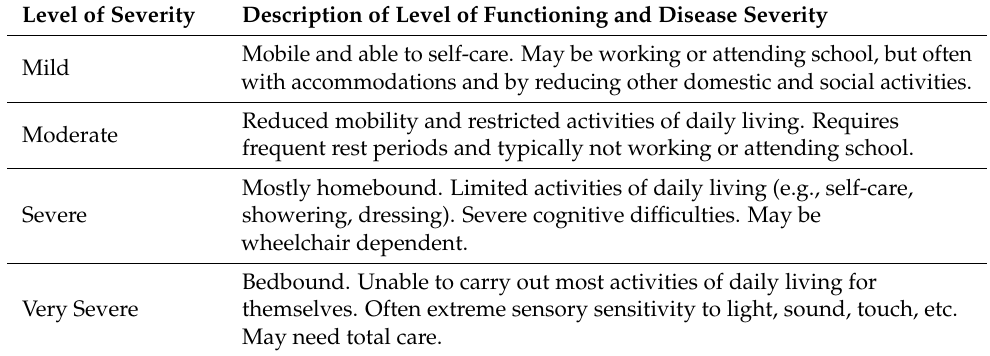
Table 1. Spectrum of Severity in ME/CFS